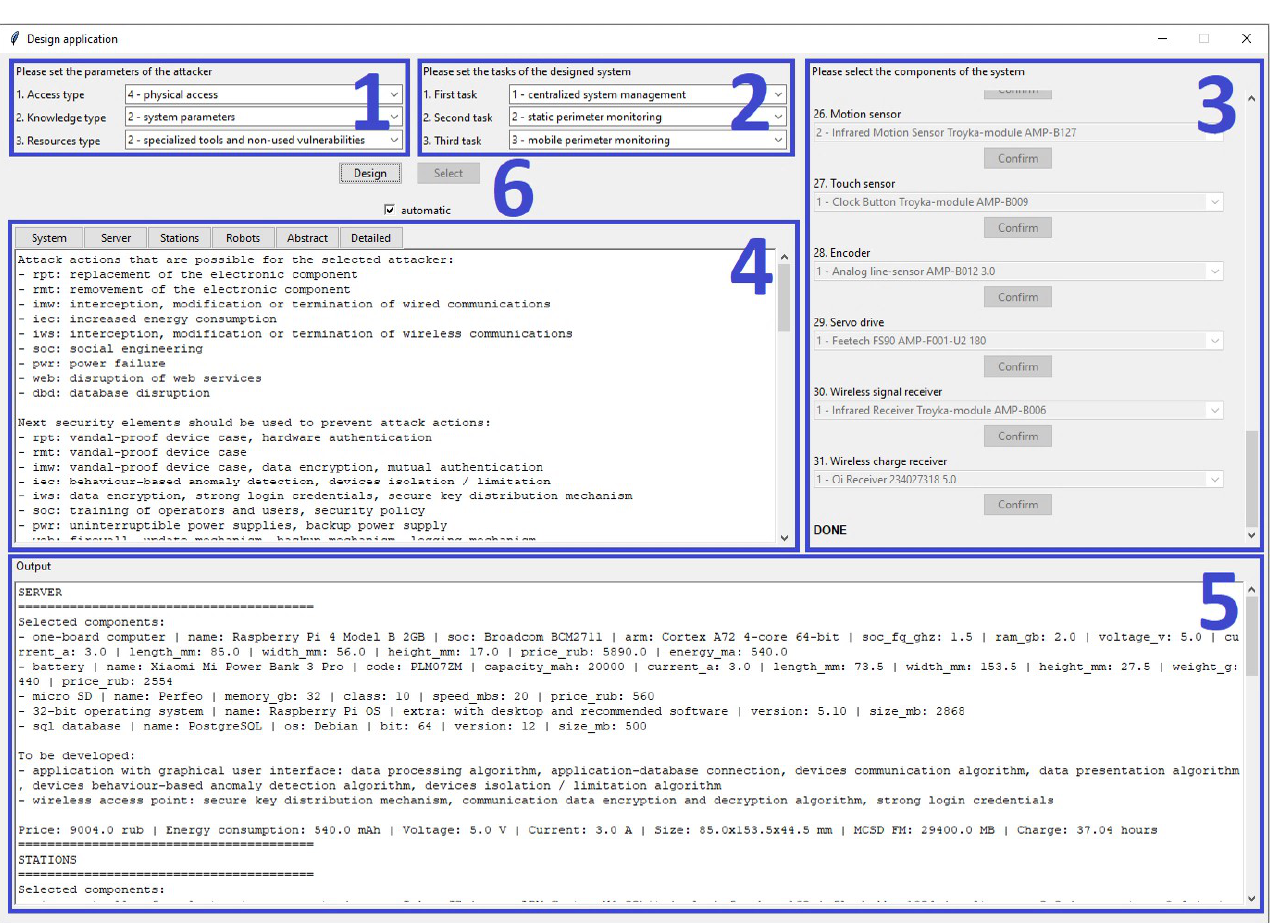
Figure 6. Interface of the application: state after the design